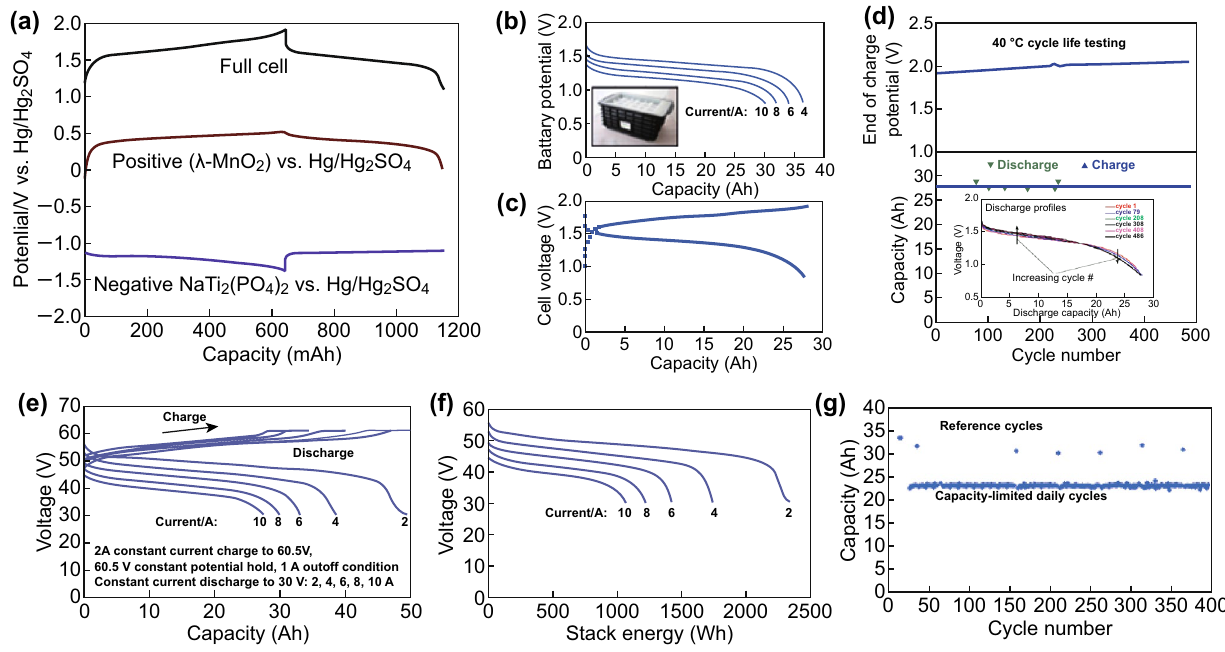
Fig. 10 a Three electrode potential-limited constant-current charge/discharge data of a full cell containing the λ -MnO 2 positive electrode and NTP negative electrode, showing the relative potential of the active materials during use. Cycle life data ( b – d ) (voltage profile shown in b ; ± 4 A constant-current charge and discharge, with a capacity-limited charge and a voltage-limited discharge) from a large-format unit with 28 Ah capacity. These data were collected at a constant temperature of 40 °C, and this test is ongoing (nearly 800 cycles logged at this point). The maximum voltage reached upon full charge is just above 2 V under 4 A current, which is less than 1.8 V after IR correction. The test is ongoing and has been under way for 14 months. e , f Performance data for an eight-battery stack showing the delivered energy as a function of current